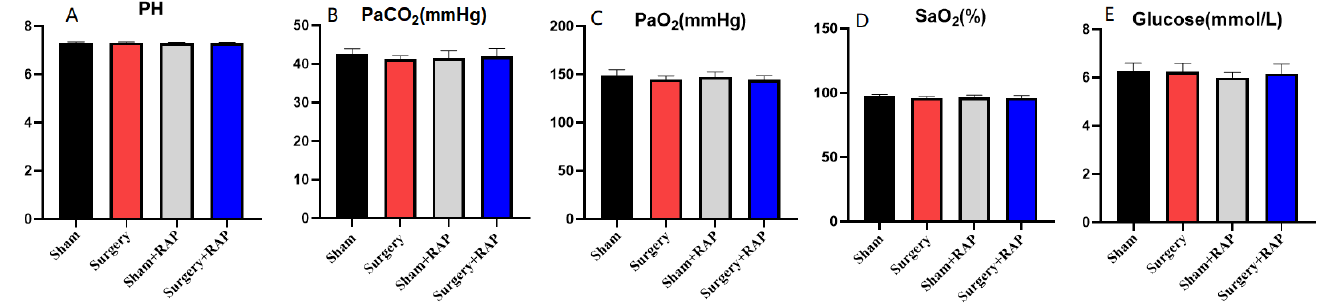
Figure 7. Exploratory laparotomy had no significant effect on blood gas or blood glucose in aged rats and was not influenced by rapamycin pretreatment. ( A ) There was no difference in the PH value of the four groups. ( B ) There was no difference in the partial pressure of carbon dioxide between the four groups. ( C ) There was no difference in oxygen partial pressure between the four groups. ( D ) There was no difference in blood oxygen saturation between the four groups. ( E ) There was no difference in blood glucose between four groups. PaCO 2 , partial pressure of carbon dioxide in arterial blood; PaO 2 , partial pressure of oxygen in arterial blood; SaO 2 , arterial oxygen saturation; Hb, hemoglobin; Glucose, blood glucose. Values represent the mean ± SEM (n = 5/group). RAP: rapamy- cin.